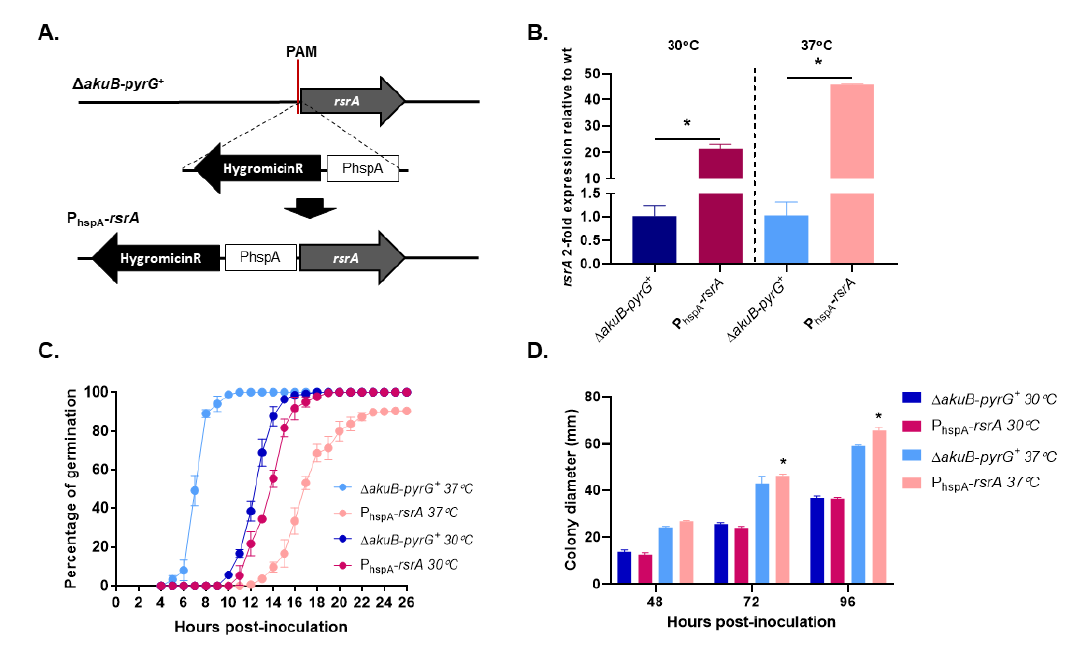
Figure 2. Overexpression of rsrA causes a significant delay in polarity establishment. ( A ) Schematic representation of rsrA promoter replacement by the constitutive Heat Shock Protein A ( hspA ) promoter. A construct containing the hygromycin resistance cassette together with one thousand base pairs of the hspA promoter was used to target a Protospacer Adjacent Motif (PAM) in the rsrA promoter. Arrows indicate the direction of gene transcription. ( B ) Expression of rsrA was determined by RT-qPCR for both control and overexpressed rsrA strains. Cycle threshold (Ct) values of rsrA were normalized to those of the endogenous standard tubA . Statistical analysis was performed using unpaired, two-tailed, Student’s t -test in GraphPad Prism v. 8.2.1 ( p ≤ 0.0024). ( C ) Polarity establishment is delayed 8 h when rsrA is overexpressed. Germination rates of control strain expressing native and overexpressed rsrA were determined as explained in Materials and Methods. ( D ) Overexpression of rsrA causes an increase in growth rate at 37 °C. Ten thousand conidia were point inoculated in the center of a GMM agar plate and incubated at 30 °C or 37 °C. Colony diameters were measured every 24 h for a 96 h period and compared among groups at each time point using 2-way ANOVA with Tukey’s test for multiple comparisons (GraphPad Prism v. 8.2.1). Asterisks indicate a statistically significant difference (adjusted p value < 0.0001) between the control and the P hspA -rsrA strains at the indicated time point.